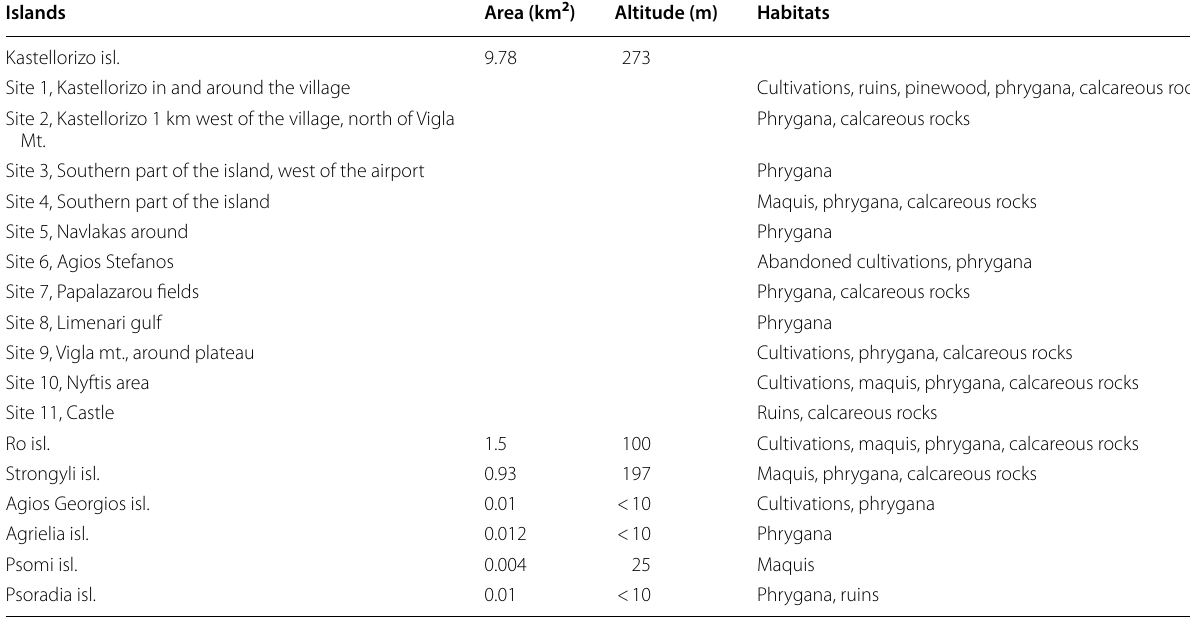
Table 2 Characteristics of islands and sites of Kastellorizo islet group